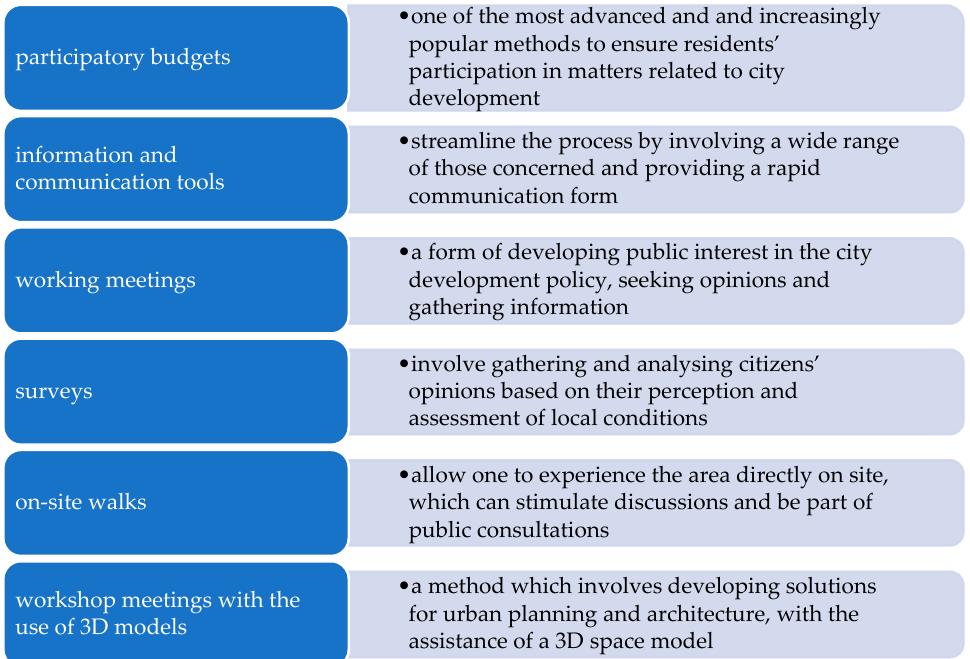
Figure 1. Own study base on the main forms, tools and instruments of public participation identified in the National Urban Policy 2023 [10].